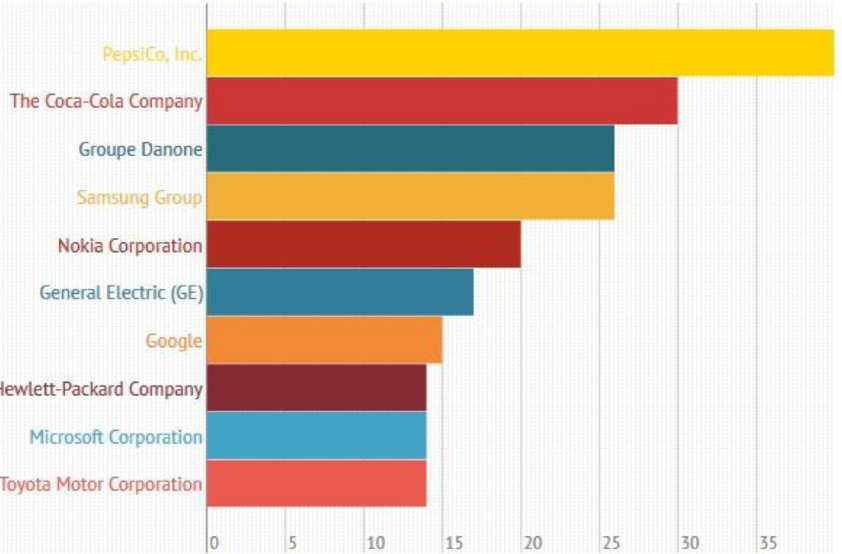
Figure 2. Companies that are using